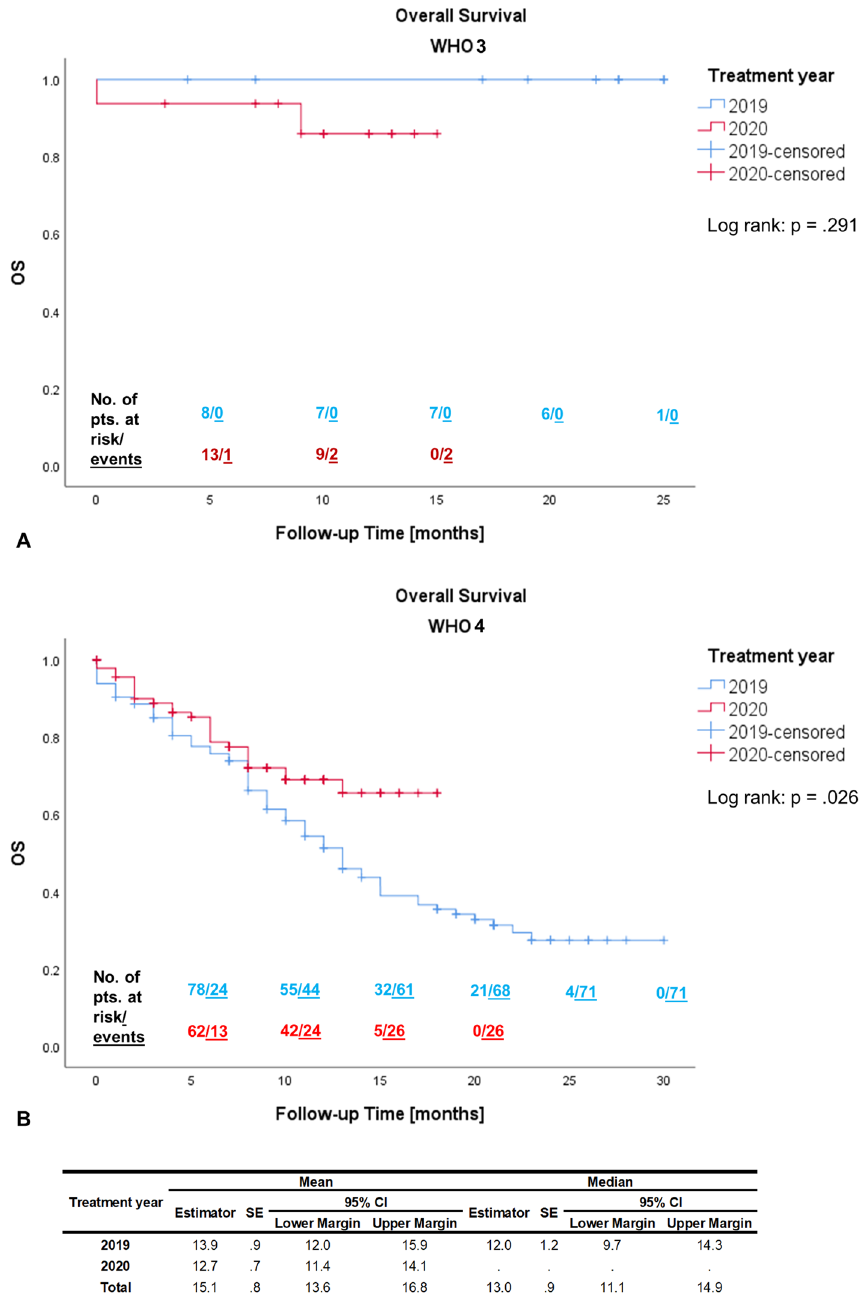
Figure 1. Kaplan–Meier estimator for Overall Survival (OS) compared between the 2019 and 2020 cohorts with WHO Grade 3 ( A ) and WHO Grade 4 ( B ) gliomas. Pts.—patients; SE—standard error; 95%CI—95% confidence interval. Kaplan–Meier statistics not conducted for WHO 3 due to censoring of all 2019